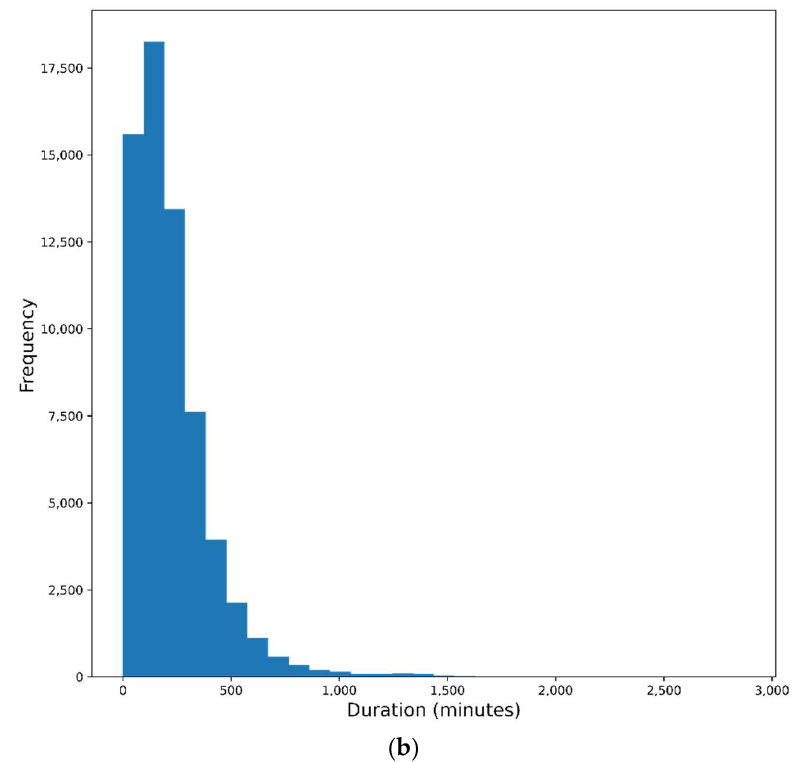
Figure 6. ( a ) Frequency of number of events during patient ED journey. Max. = 39, min. = 2, and ave. ~ 8. ( b ) Frequency distribution of duration of patient ED journey.